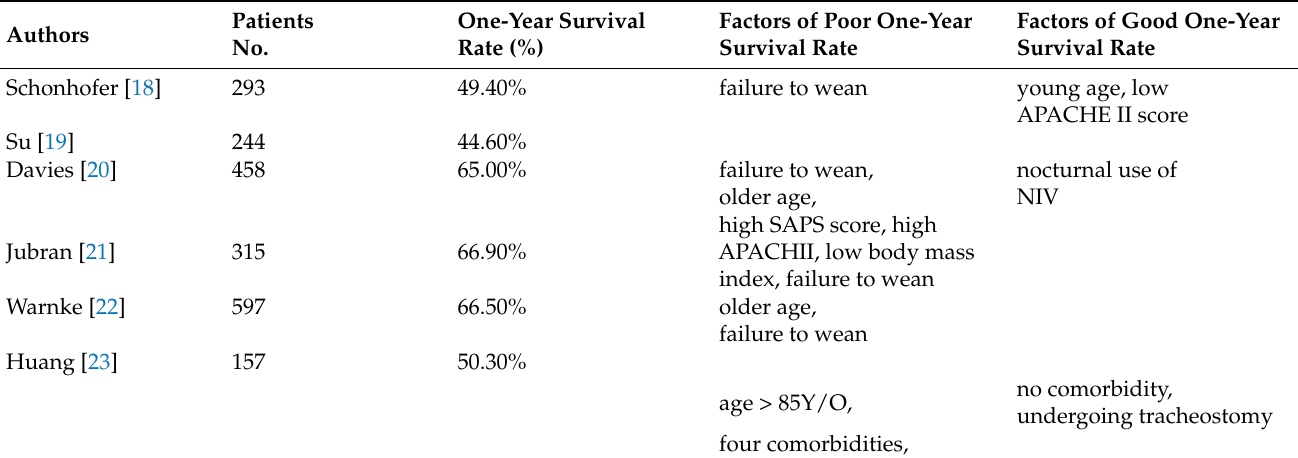
Table 4. The one-year survival of patients discharged after successfully weaned from prolonged mechanical